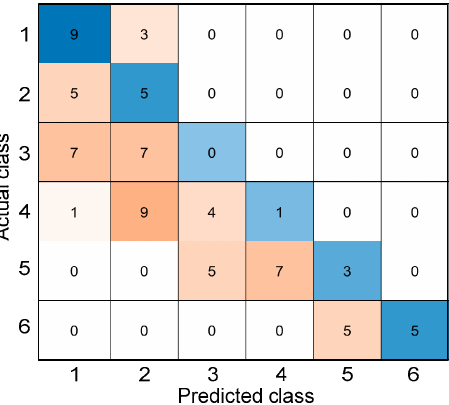
Figure 8. Variation of ( a ) relative P-wave velocities (cid:3436) and the literature with increasing temperature and ( b ) labeled P-wave velocities. Note that DC in ( b ) means damage class of concrete.